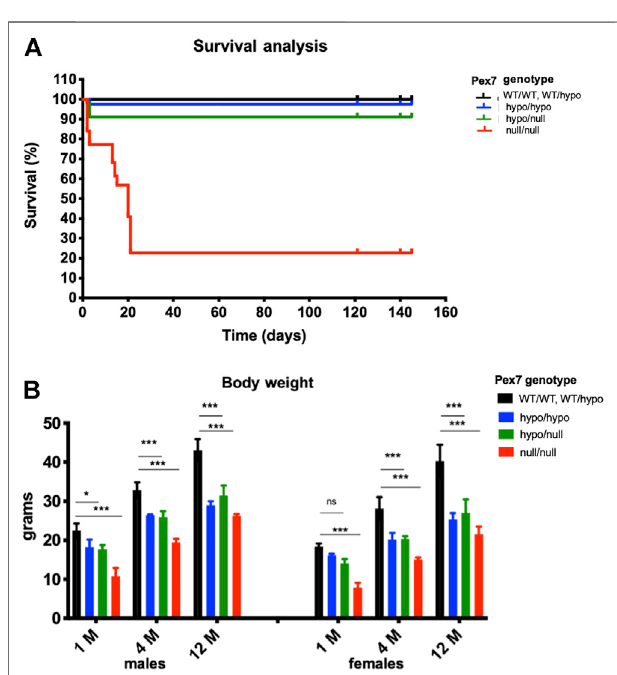
FIGURE 3 | Pex7 genotype correlates with survival rates and weight gain. Kaplan – Meier plots showing the percentage of survival of Pex7 de fi cient mice ( n = 41 – 60 per genotype). Analyzing the survival data by log rank tests showed signi fi cant differences between genotypes ( p < 0.001) in accordance to the severity of Pex7 genotype (A) . Graded and signi fi cant reductioninbodyweightaccordingto Pex7 genotypeseverityisfoundin Pex7 mutants compared to controls at 1, 4, and 12 months (M) of age ( n = 10 – 12 per genotype) (B) . ns: nonsigni fi cant, * p < 0.05, ** p < 0.01, *** p < 0.001, **** p <